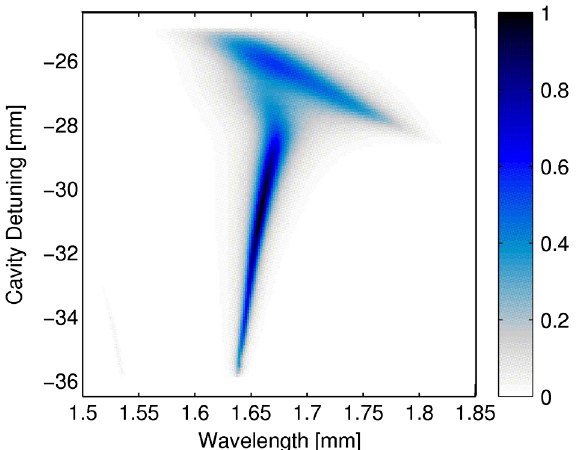
FIG. 3. Relative optical spectral density obtained at saturation for the resonant wavelength of 1592 (cid:1) m versus different cavity detuning